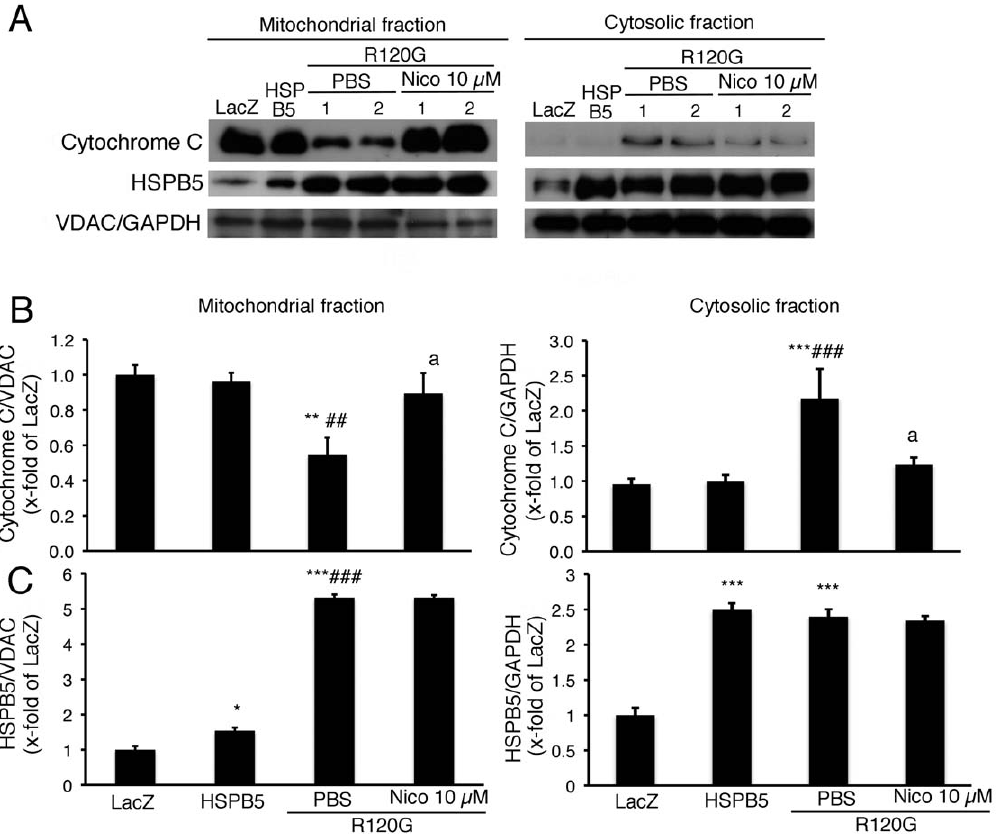
Figure 2. Cytochrome c levels of mitochondrial fraction isolated from the cardiomyocytes expressing HSPB5 R120G (R120G) with or without Nico treatment. (A) Typical pictures of Western blot analysis. Quantitative analysis of cytochrome c (B) and HSPB5 (C) in mitochondrial and cytosolic fractions isolated from the cardiomyocytes. GAPDH was used as a loading control in the cytosolic fraction and the voltage-dependent anion channel (VDAC) was used in mitochondrial fraction. *p , 0.05, ** p , 0.01, ***p , 0.001 vs. the cardiomyocytes infected with LacZ (LacZ), ## p , 0.01, ### p , 0.001 vs. the cardiomyocytes infected with wild-type HSPB5 (HSPB5), ap , 0.05 vs. cardiomyocytes infected with R120G treated with PBS.